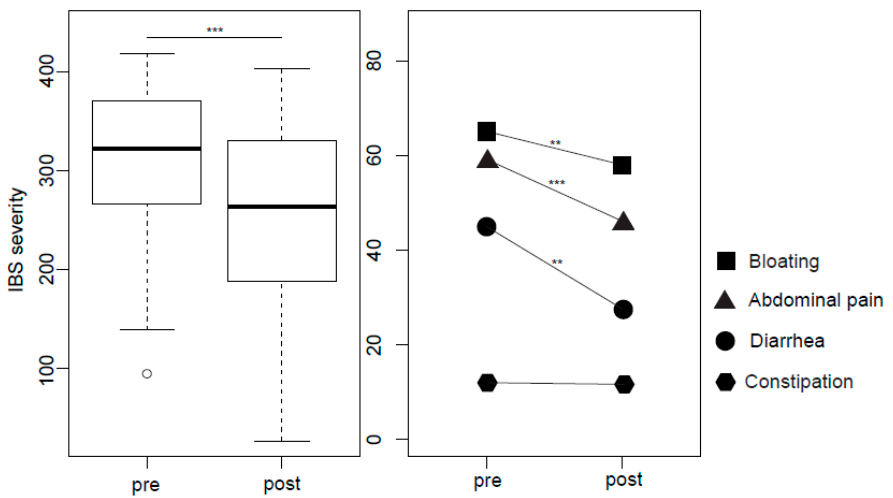
Figure 4. IBS (irritable bowel syndrome) severity ( a ) and IBS single symptoms ( b ) before and after GHT, ** p < 0.01, *** p < 0.001.